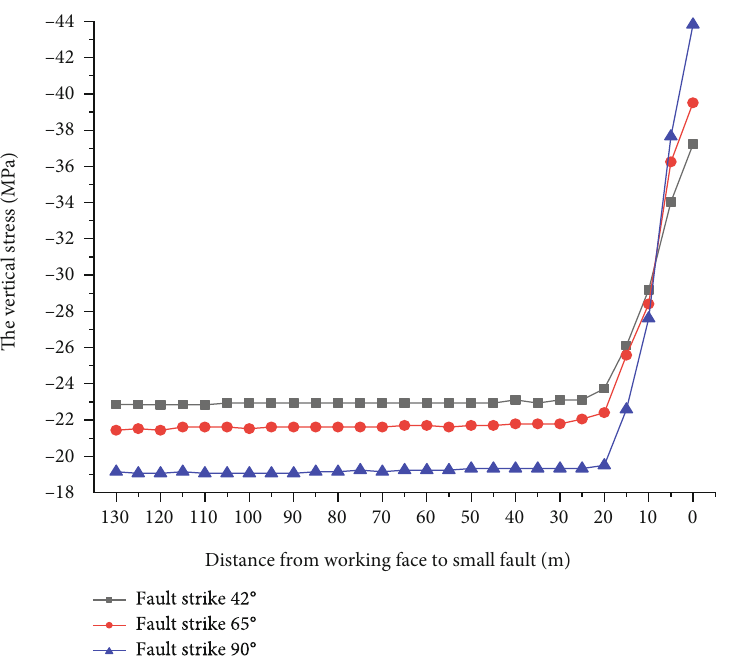
Figure 9: Line diagram of stress change at monitoring point A controlled by small fault with di ff erent strikes. The black dotted line represents a fault strike of 42 ° , the red dotted line represents a fault strike of 65 ° , and the blue dotted line represents a fault strike of 90 °